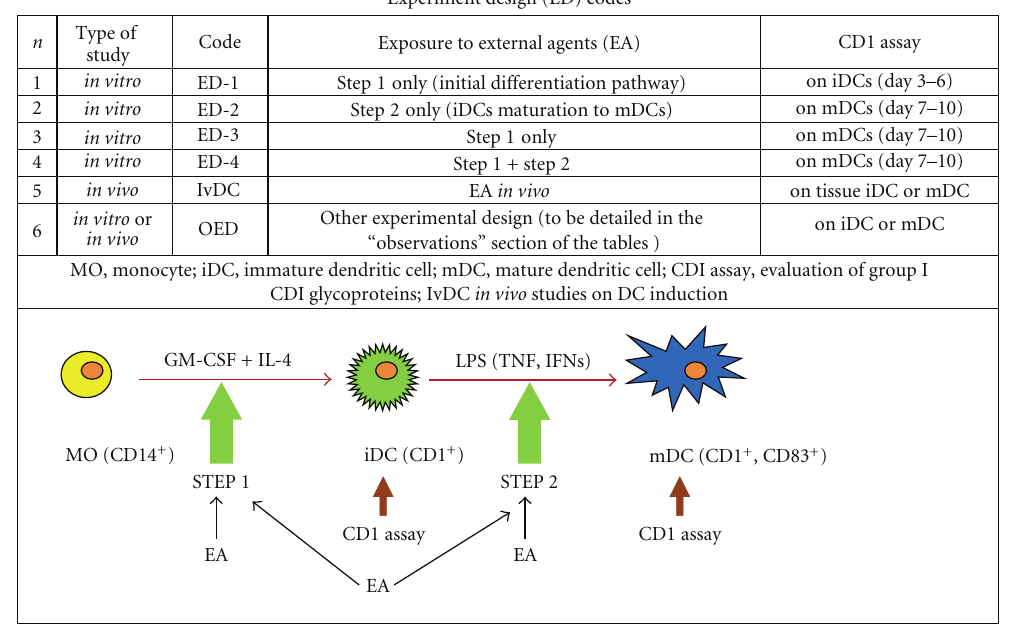
Figure 2: E ff ect of external agents on group I CD1 glycoprotein